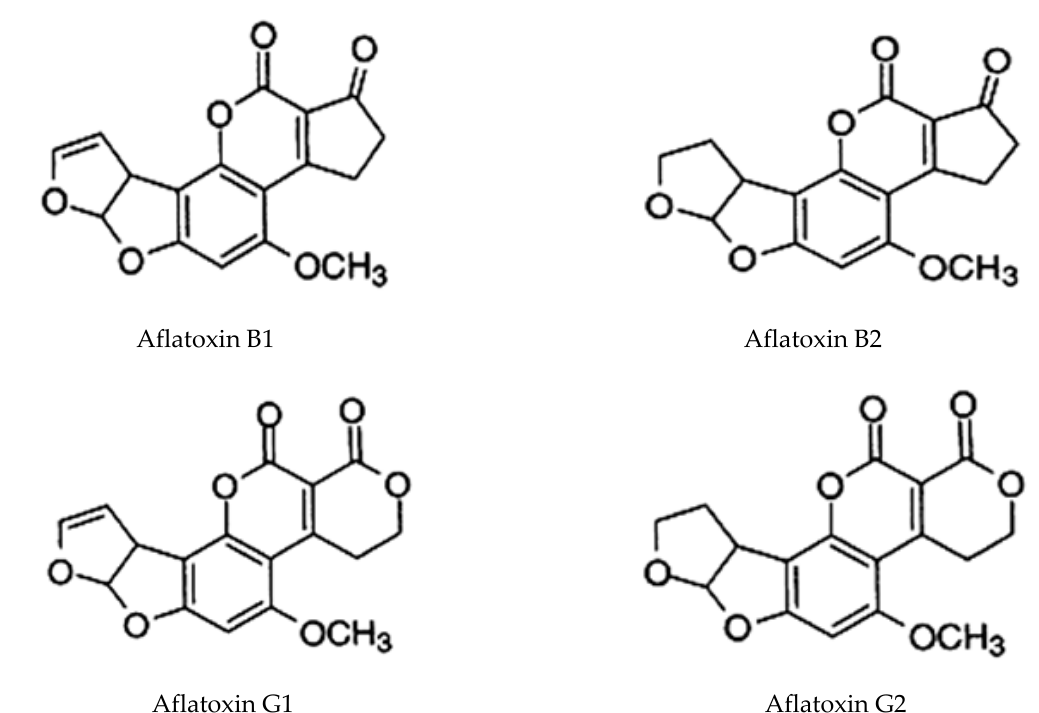
Figure 4. Chemical structure of aflatoxin B1, B2, G1, and G2 [59]. Copyright: African Journal of Food Science, 2010.